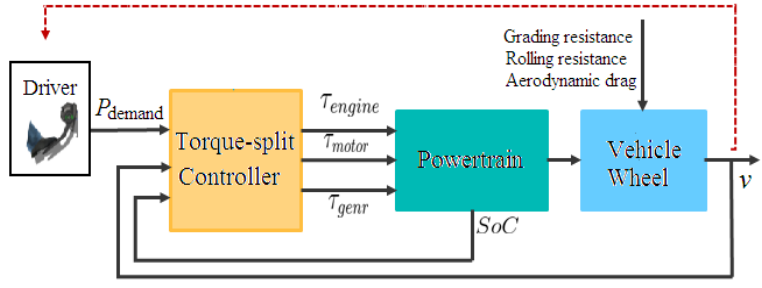
Figure 11. Schematic of HEV system with torque-split control in simulation.